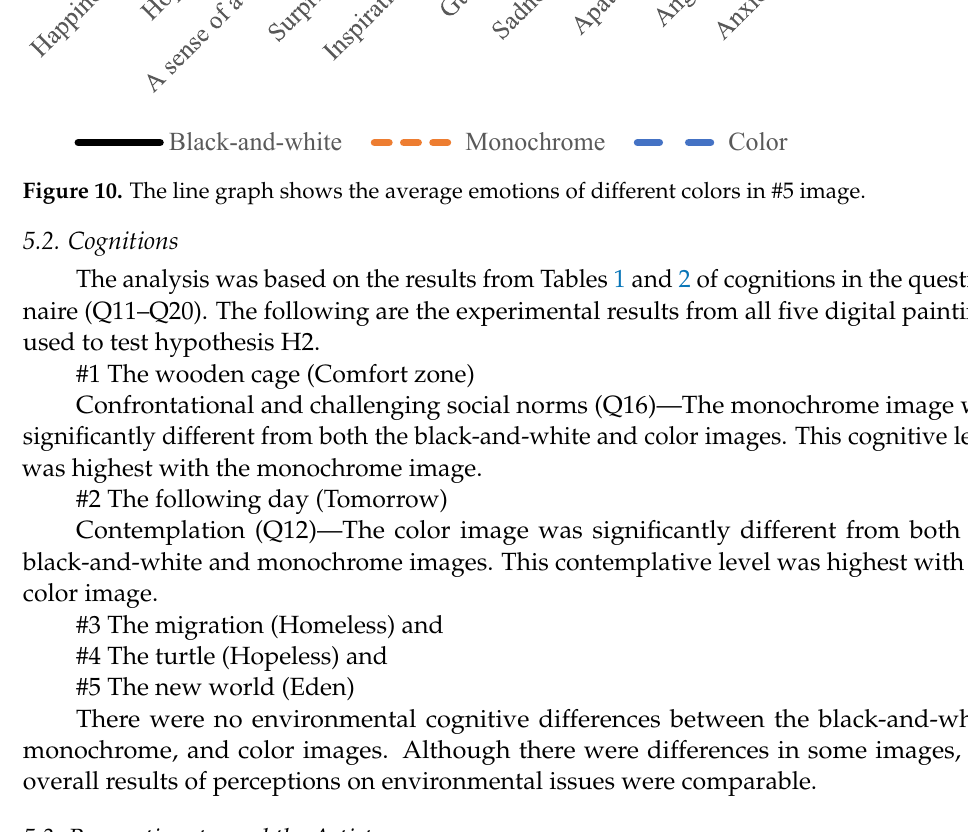
Table 3. The Kruskal–Wallis H test results of perspectives toward the artist according to different